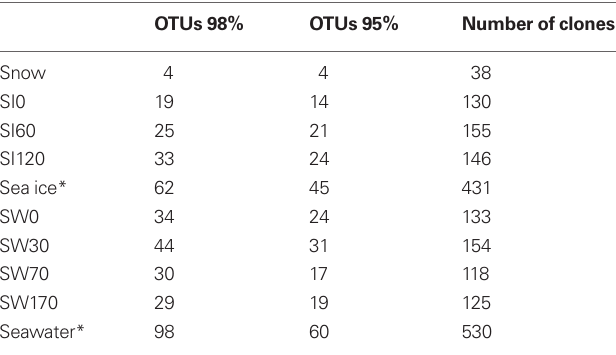
Table 1 | Number of OTus and clones in the North Pole clone libraries. OTus 98% OTus 95%